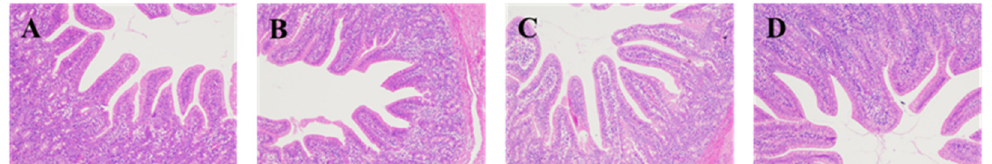
Figure 1. Effects of protease supplementation on duodenal morphology of weaned piglets: ( A ) the control group; ( B ) adding 150 mg/kg protease; ( C ) adding 300 mg/kg protease; ( D ) adding 300 mg/kg protease.